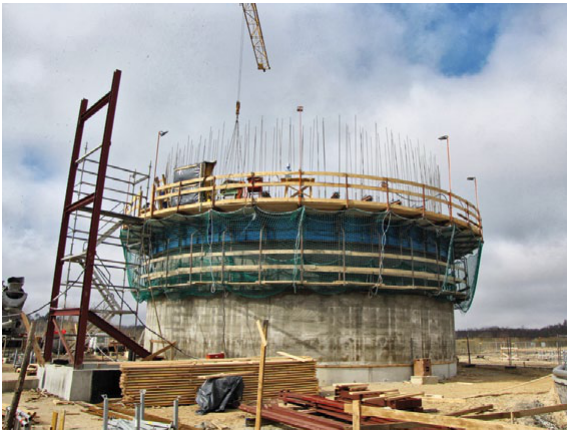
Fig. 9. Continuity concreting moment of sludge tank by moving formwork